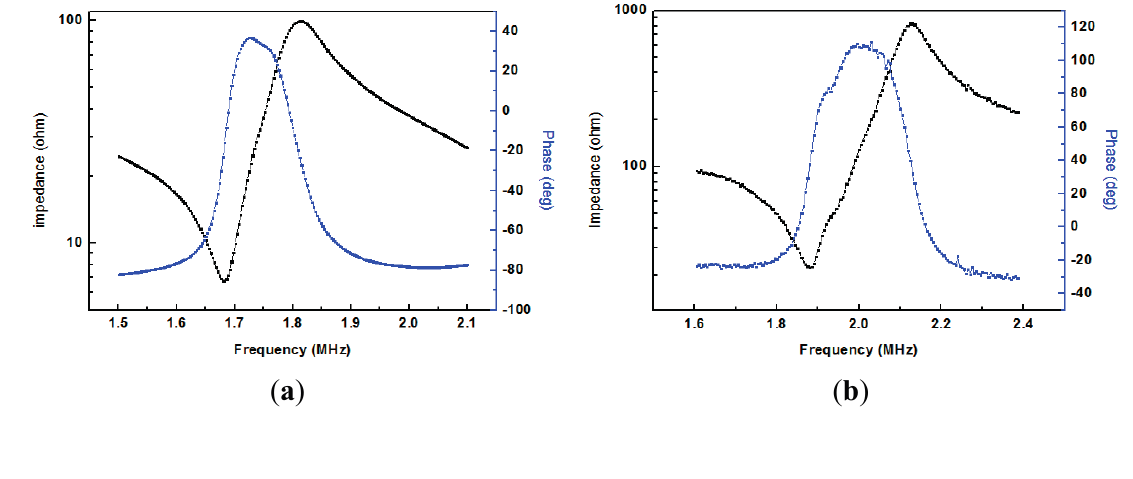
Figure 3. The frequency dependent impedance and phase angle of the as-fabricated TCD transducer: ( a ) PZT ceramic-based transducer; ( b ) PMN-PT single crystal-based